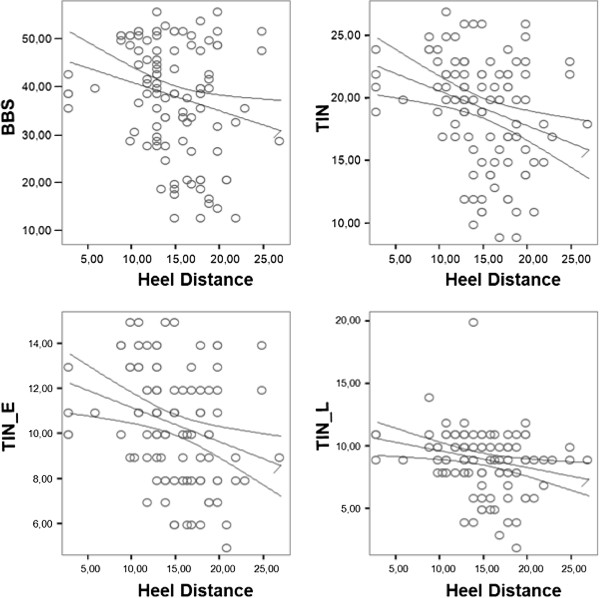
Correlation analysis between heel distance and clinical scales. Correlation between HD and BBS, TIN, TINE, and TINLOC.